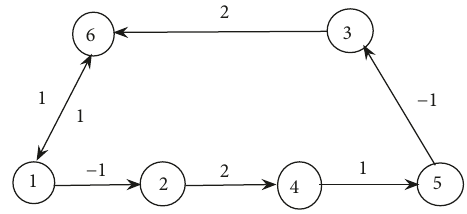
Figure 1: Communication graph G among the 6 agents.